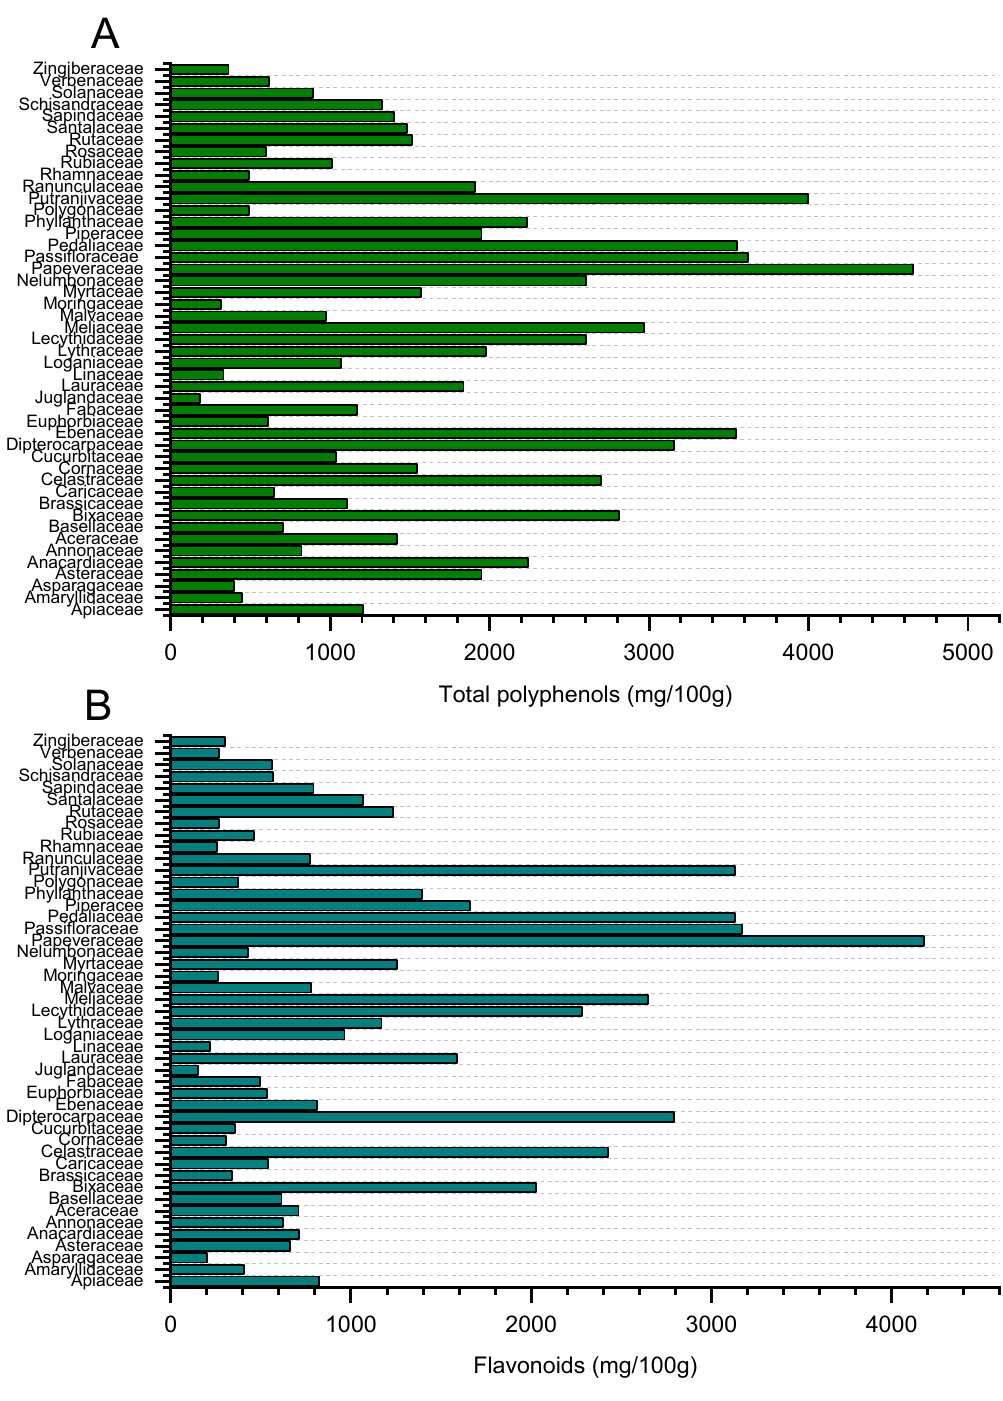
Figure 1. Total polyphenol (panel A ) and total flavonoid (panel B ) contents grouped by